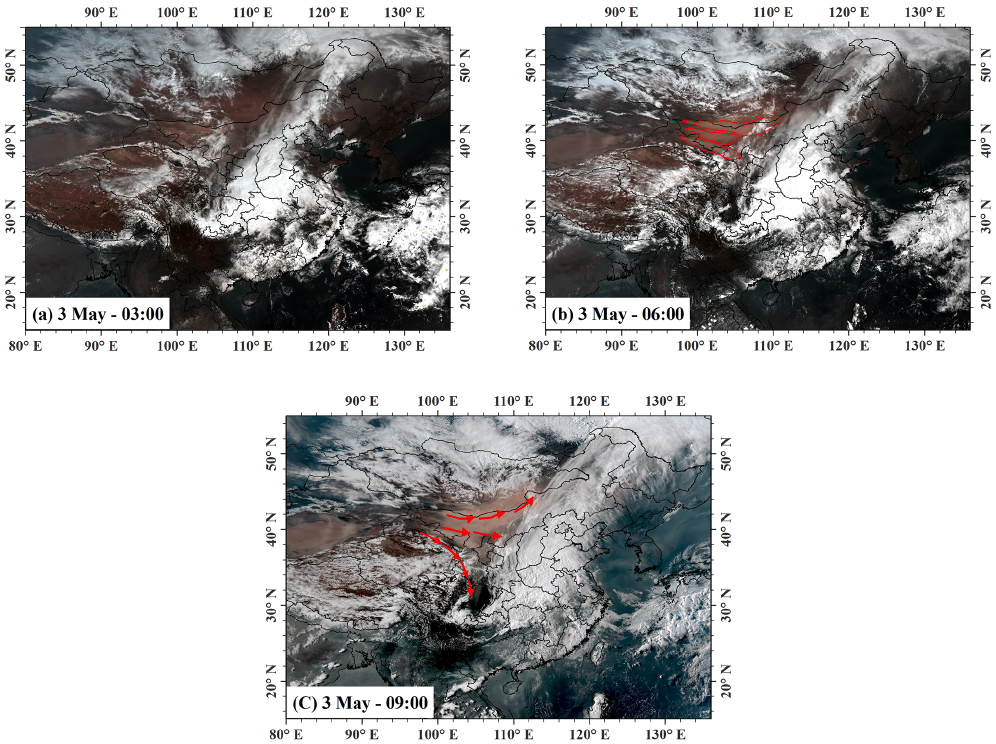
Figure 6. True-colour composite AHI images of mainland China from AHI data from 03:00 to 09:00UTC on 3 May 2017: (a) 03:00, (b) 06:00, and (c) 09:00. The red polygons in (b) are dust clusters. The arrows in (c) represent the dust transport directions. Table 1. The cities and locations of the 14 air quality stations to examine the propagation of dust particles. City (site) Longitude ( ◦ ) Latitude ( ◦ ) City (site) Longitude ( ◦ ) Latitude ( ◦ ) Bayannao’er (BYN) 107.5936 40.916 Shanghai (SHS) Changsha (CSS) 112.9958 28.3586 Taiyuan (TYS) Chengde (CDS) Guangyuan